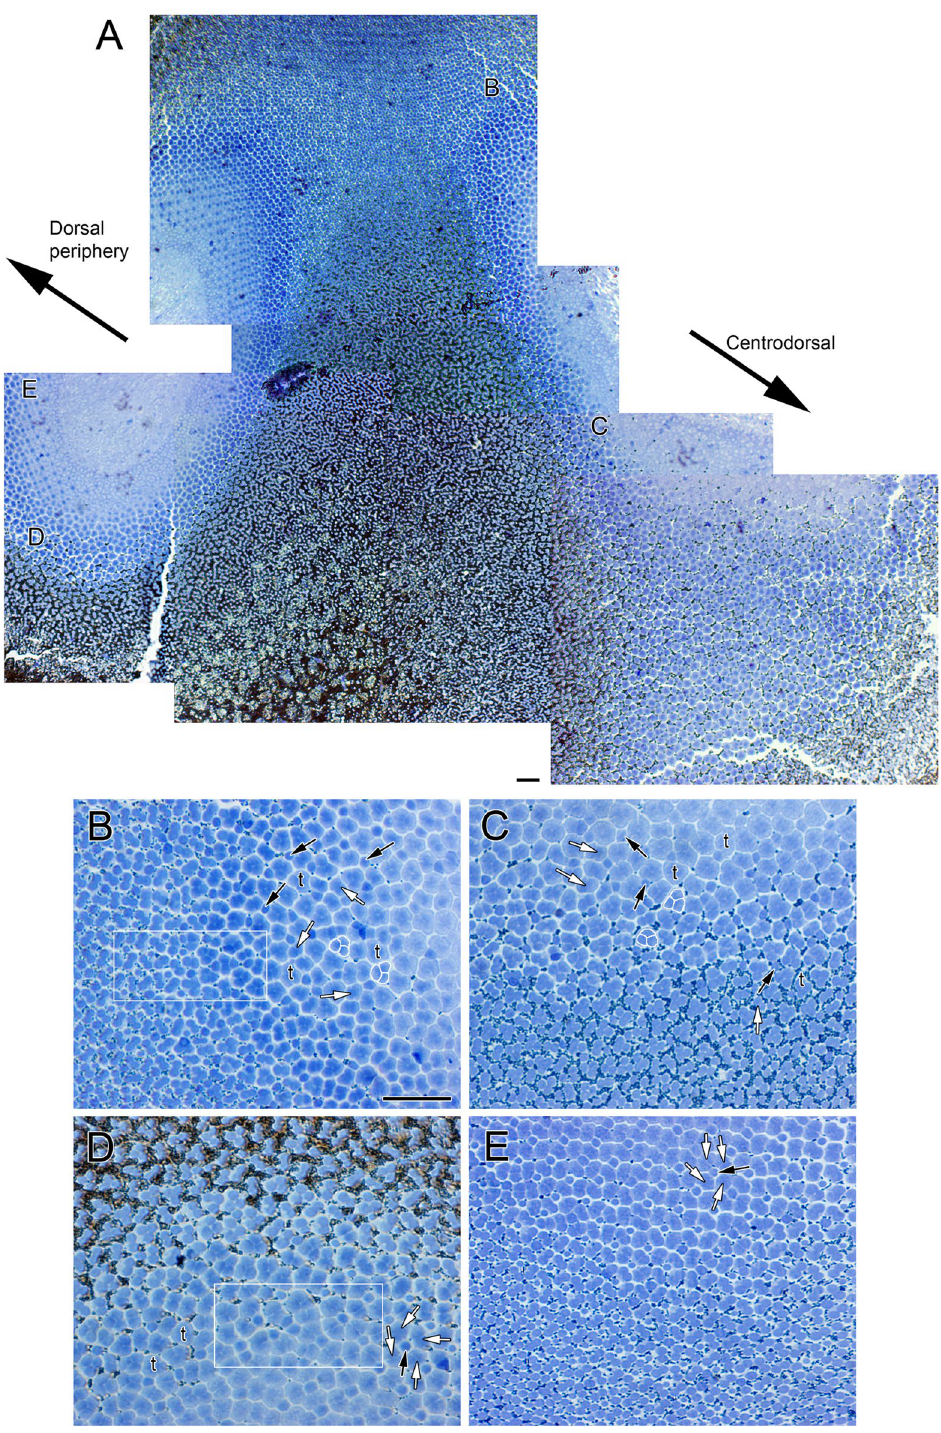
Figure 3. Micrographs of tangential EPON sections showing cone distributions from the dorsotemporal retinal quadrant at 878 ATU. ( A ) View stitched together from multiple micrographs spanning the central to peripheral retina. The centrotemporal retina comprises three different cone types (single, double and triple cones) arranged in various formations whereas the retinal periphery shows a square mosaic. ( B – E ) Cone distributions from different areas of the field shown in ( A ) and indicated by the same letters (in A ). ( B , D ) Cone distributions at interfaces between the more central, triple cone-occupied area and the peripheral, square mosaic area (white rectangles); triple cones (t, white contours) are common among double and single cones toward the central retina. ( C ) Area of central retina illustrating larger cells and prominent triple cone presence. ( E ) Square mosaic toward the periphery of the retina. Other symbols and abbreviations as per Fig. 2. Scale bars in ( A ) and ( B ) equal 10 µm; scale bar in ( B ) holds for ( C – E